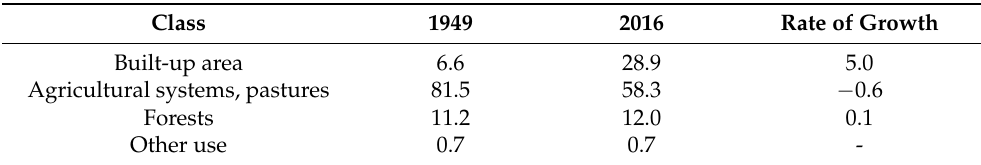
Table 1. Landscape composition (%) by year in the study area (four classes); other use includes wetlands, water bodies, rocks, sand; rate of growth was calculated as annual per cent change over time.